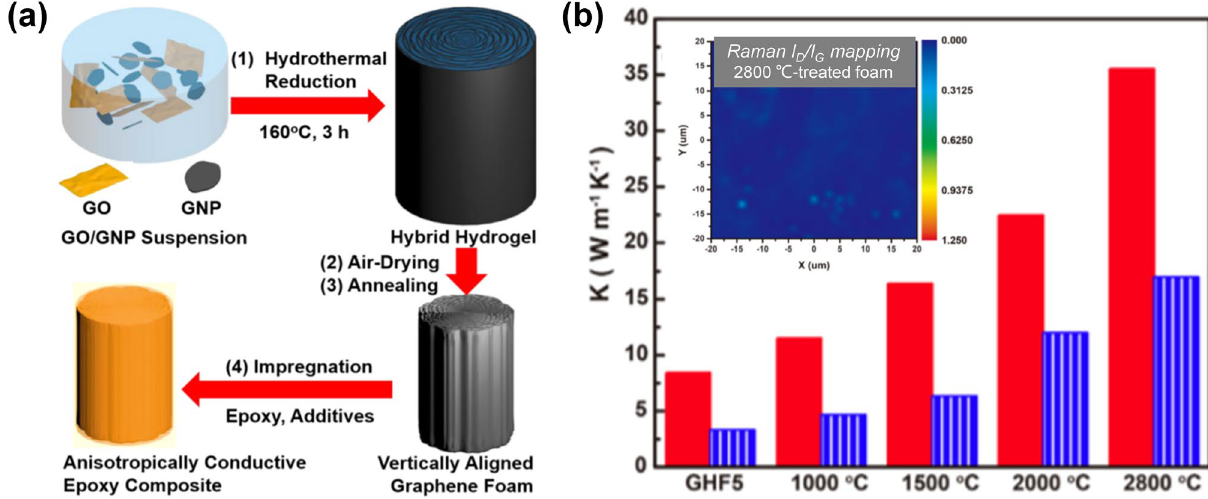
Fig. 16 a Schematic illustrating the fabrication of conductive epoxy composite with vertically aligned RGO/GNP hybrid foam. b Through‑plane conductivity (red column) and in‑plane conductivity (blue column) of the epoxy composite containing the vertically aligned RGO/GNP hybrid foam annealed at different temperatures (inset: Raman I D / I G mapping)